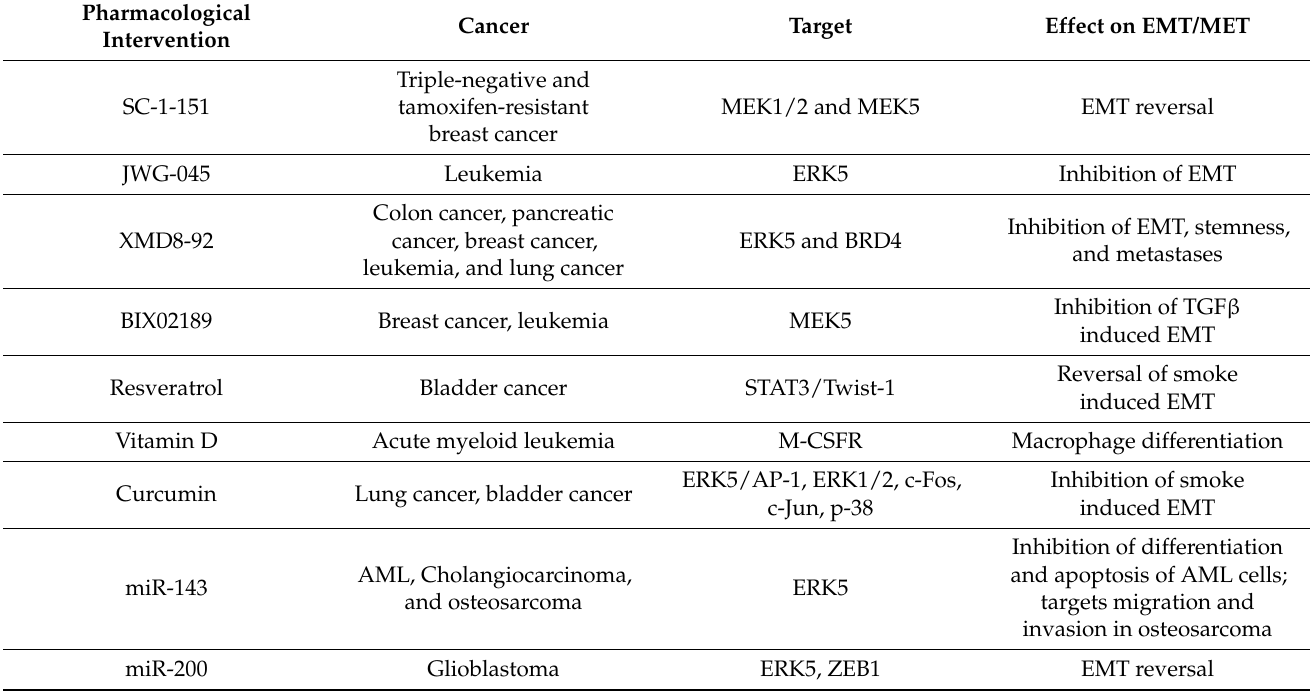
Table 2. Pharmacological interventions for targeting the ERK5 pathway to inhibit or reverse